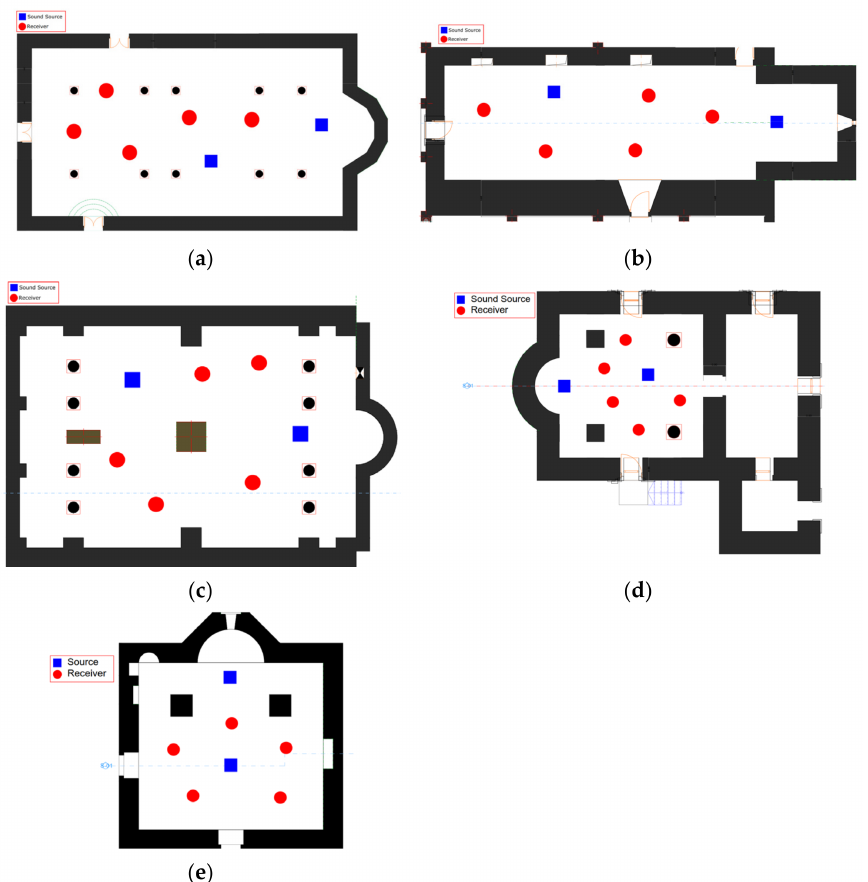
Figure 12. Location of the equipment during the acoustic measurement inside the five churches: St